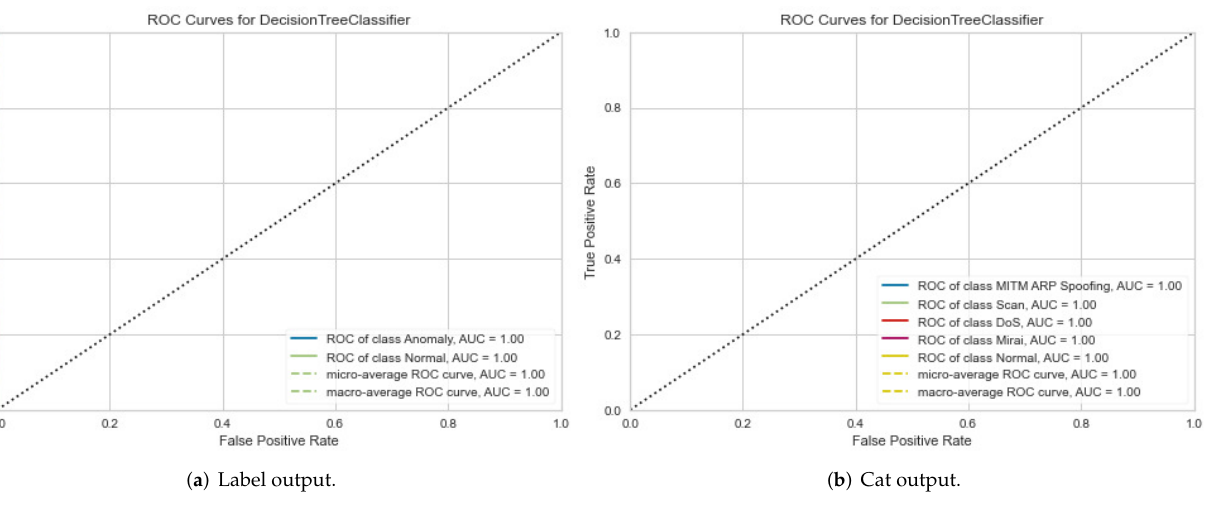
Figure 6. ROC curve results for IoTID20 dataset in two cases: ( a ) Binary class output